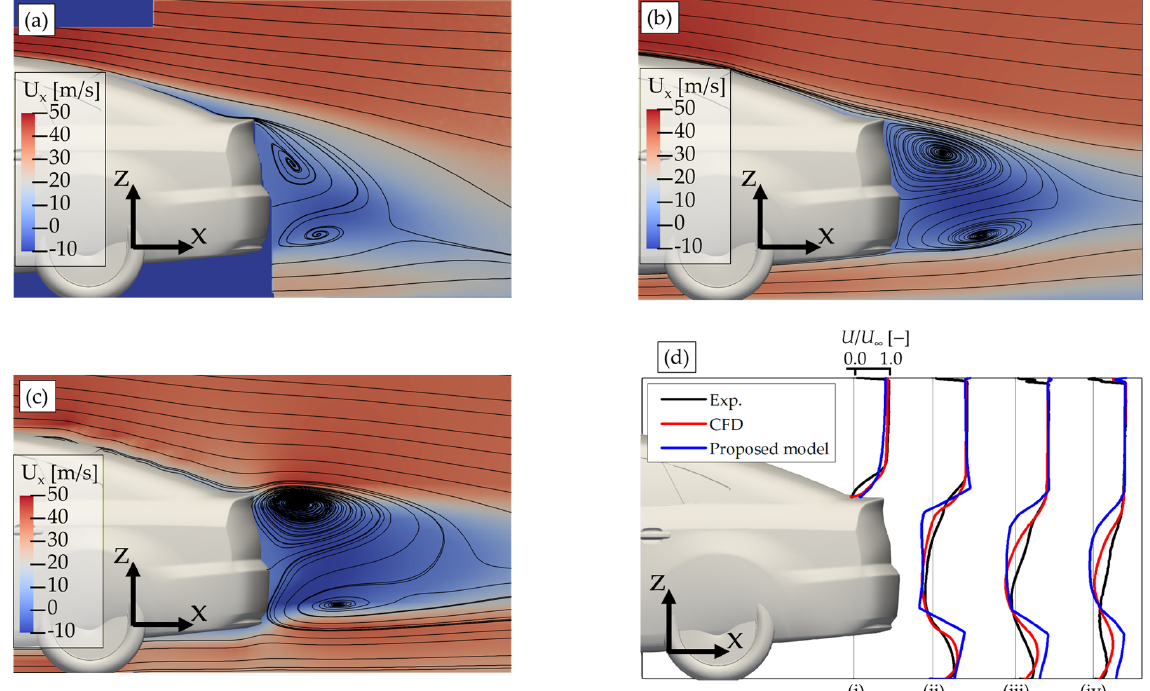
Figure 10. Streamlines and velocity profile in the near-wake region of the fastback vehicle, along the centerline of the y -direction, in the x - z plane. ( a ) Experiment [8], ( b ) CFD model, ( c ) Proposed model ( d ) comparisons of the velocity profiles. Velocity profiles are drawn from the front of the vehicle at downstream positions of ( i ) 1089 mm, ( ii ) 1199 mm, ( iii ) 1314 mm, and ( iv ) 1422